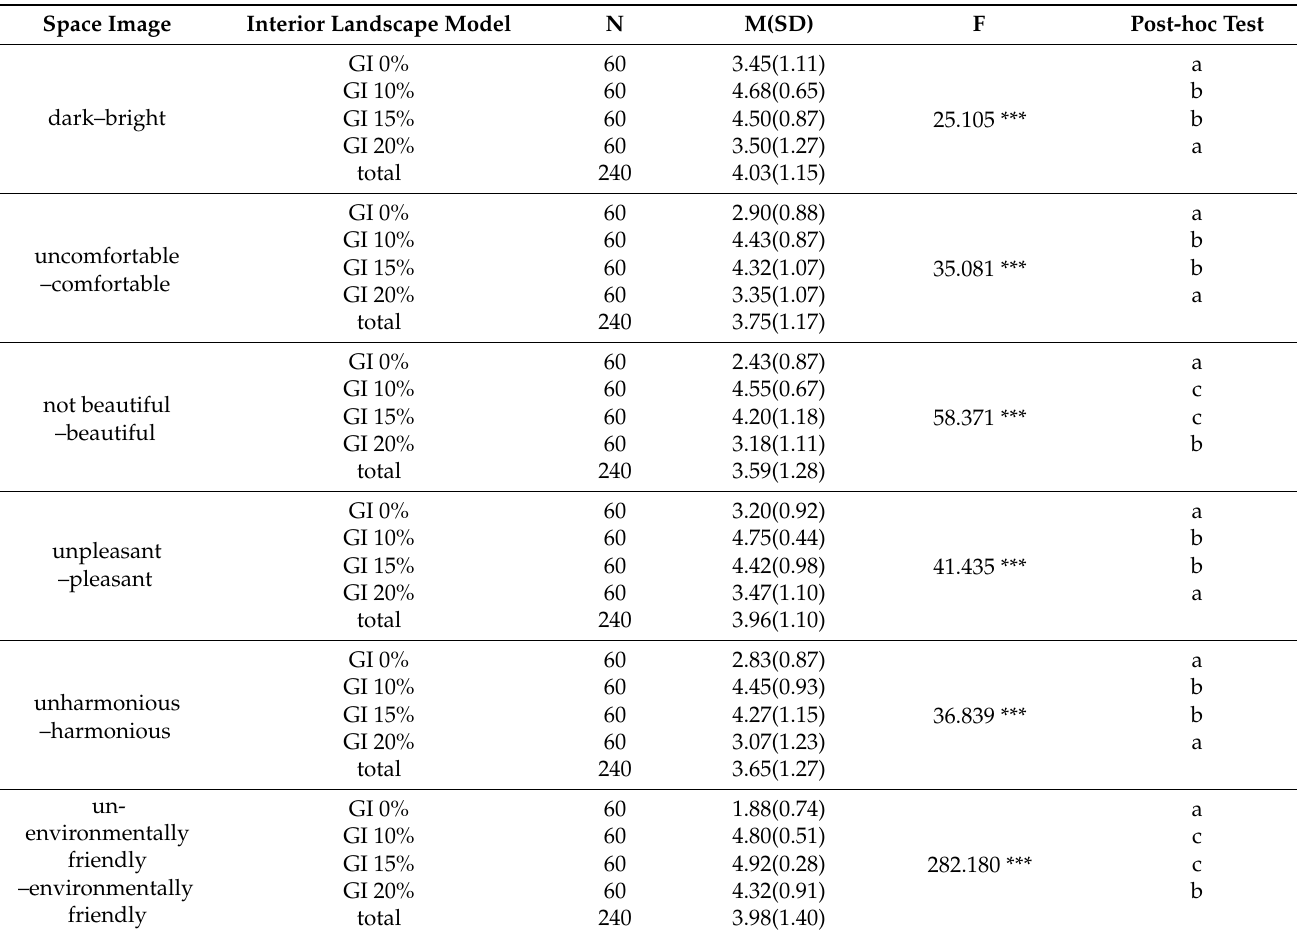
Table 11. Space Image Difference Analysis of Interior Landscape Models in Ground Subway according to